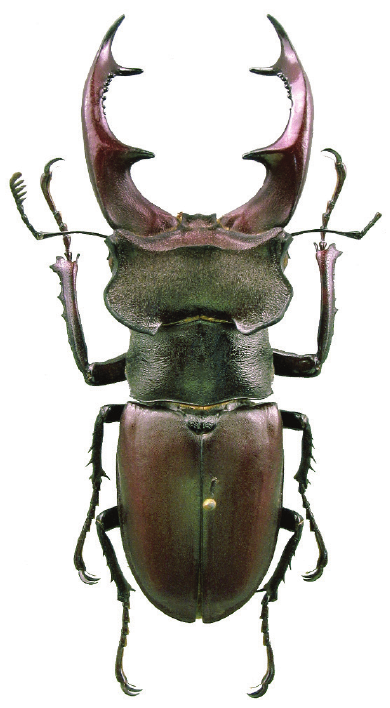
Figure 6. L. cervus from a contact area with L. tetraodon in Central Italy (Northern Latium, northern Rome province, Manziana; photo by M.